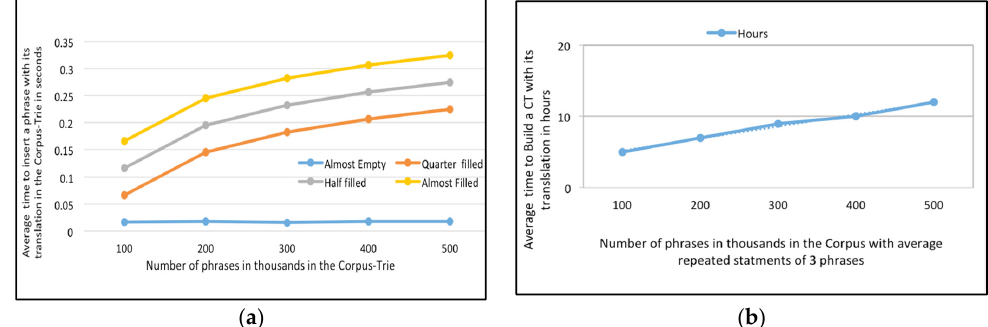
Figure 6. ( a ) Average time to insert a phrase with its translation in the Corpus-Trie in seconds versus Number of phrases in thousands in the Corpus-Trie for the English-French parallel corpora; ( b ) The cost of Corpus-Trie construction (the number of phrases which are repeated in the corpus is in the average of three phrases) for the English-French parallel